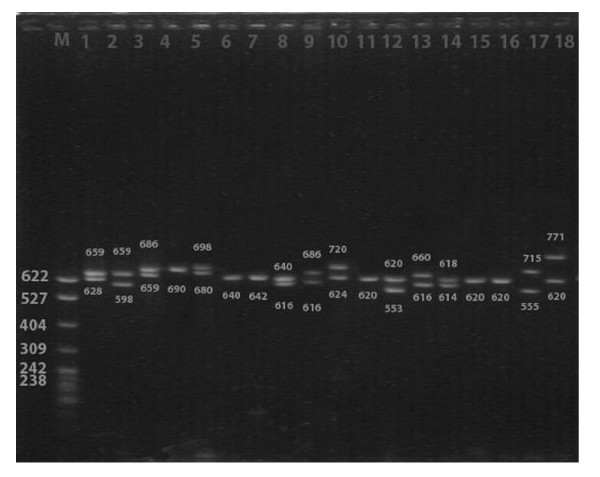
Electrophoretic result of PCR products of the samples in Hei Yi Zhuang. Lane M, 322 bp marker ladder (PBR322/MspI); Lanes 1–3, 5, 8–10, 12–14, 17, and 18, heterozygotes (two straps); Lanes 4, 6, 7, 11, 15, and 16, homozygotes (one strap)